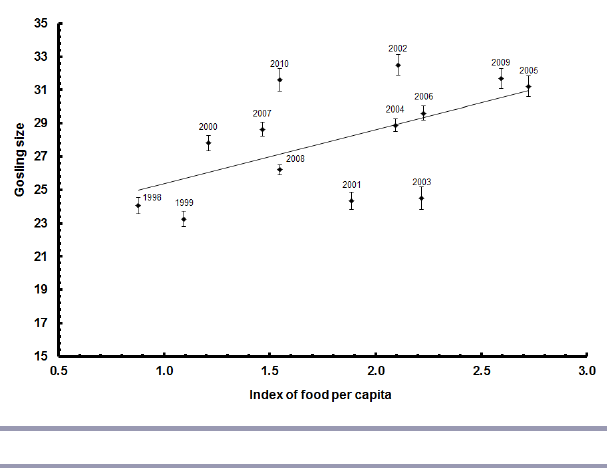
Fig. 5 . The relationship between individual gosling size at banding and an annual index of per capita forage abundance (after controlling for the effects of hatch timing relative to plant phenology) on Akimiski Island, Nunavut. Goslings were measured from 1998-2010, and forage was sampled annually at five separate locations in two forage types during the same period that goslings were measured. Bars are 95% confidence limits.